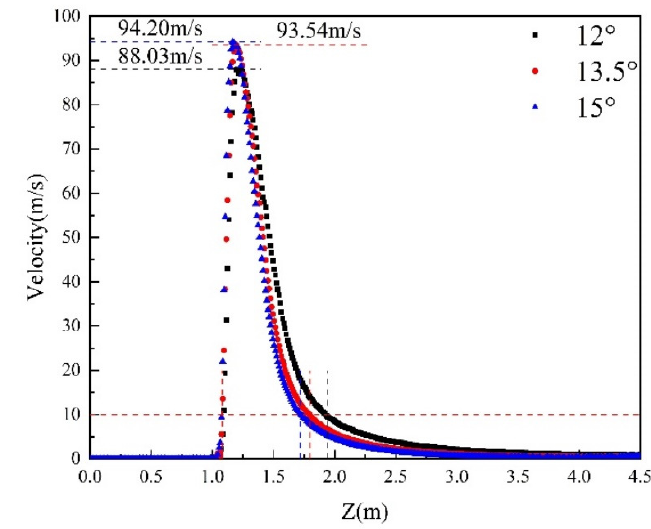
Figure 10. Velocity of the casting slab surface under different angles.